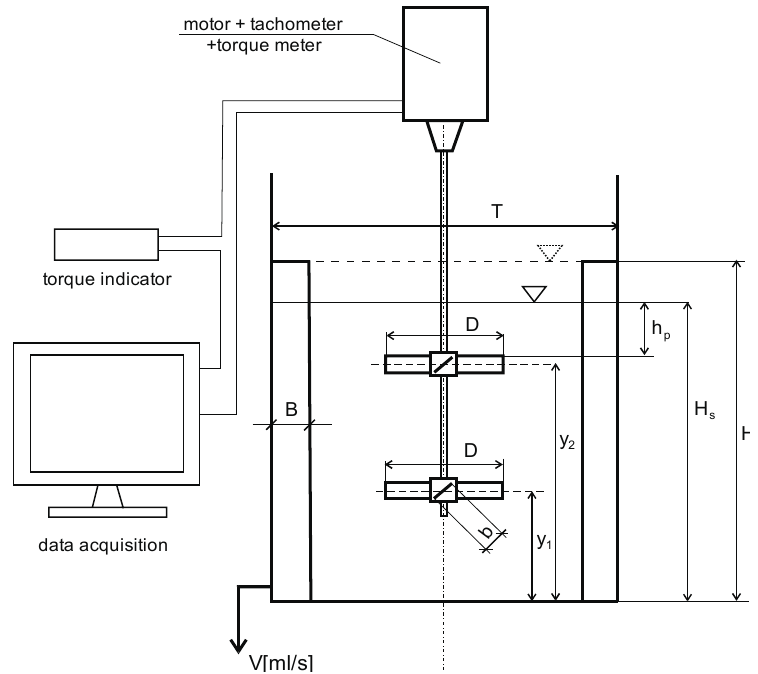
Figure 1. Diagram of the experimental equipment.